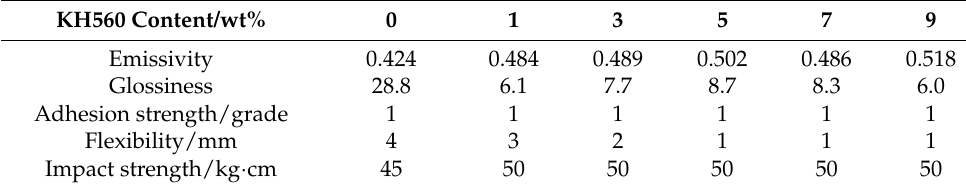
Figure 4. SEM photos of coatings with contents of KH560 of 0 wt% ( a , c ) and 7 wt% ( b , d ). Table 3. Performance index of coatings with different contents of